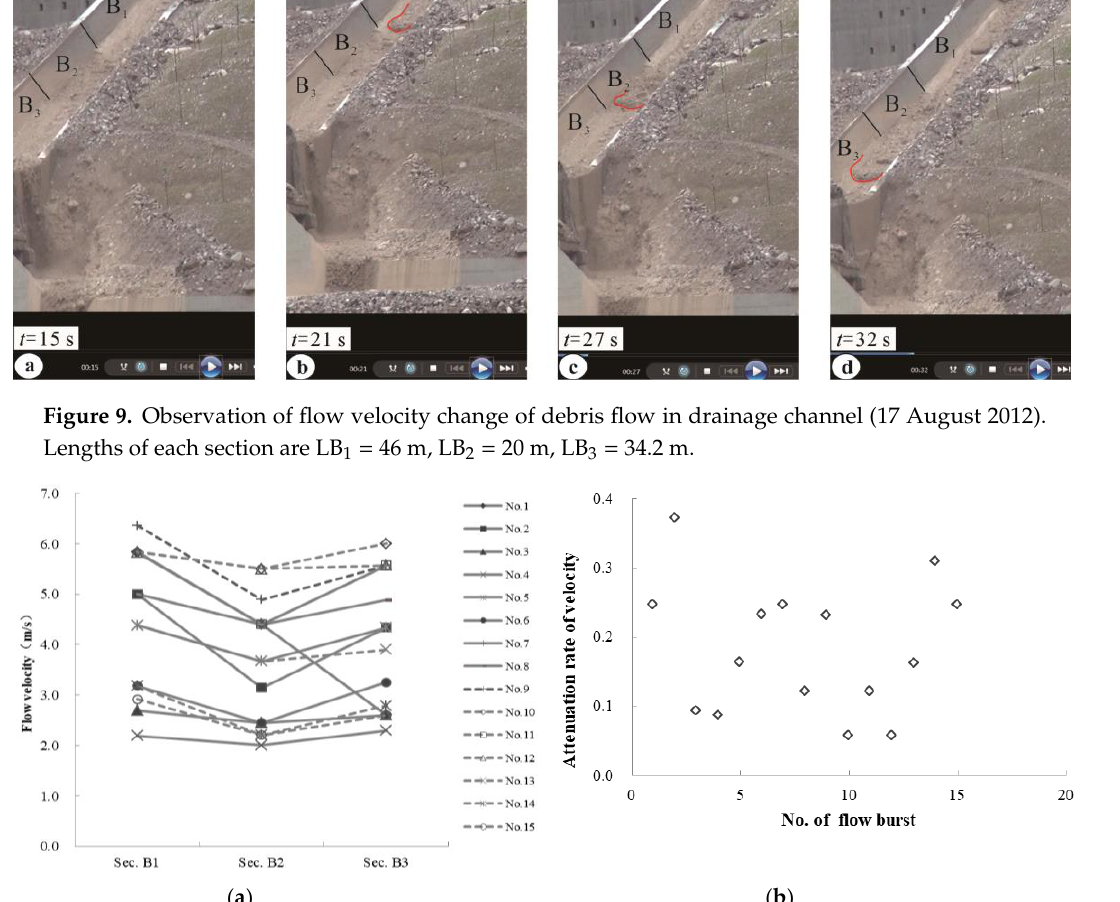
Figure 9. Observation of flow velocity change of debris flow in drainage channel (17 August 2012). Lengths of each section are LB 1 = 46 m, LB 2 = 20 m, LB 3 = 34.2 m.